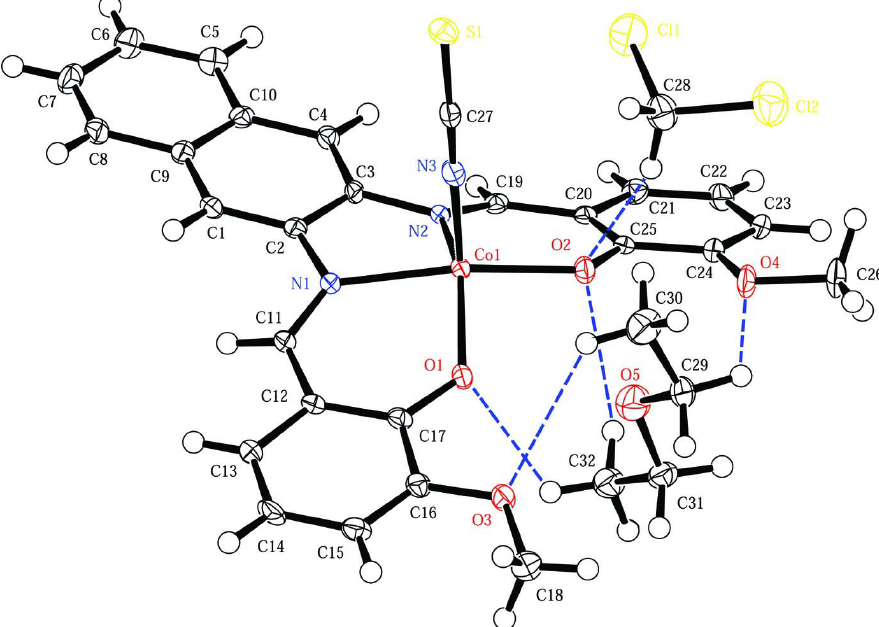
Figure 1 A view of the title molecule, showing the atom-labelling scheme. Displacement ellipsoids are drawn at the 50% probability level. Weak hydrogen bonds are indicated with dashed lines.